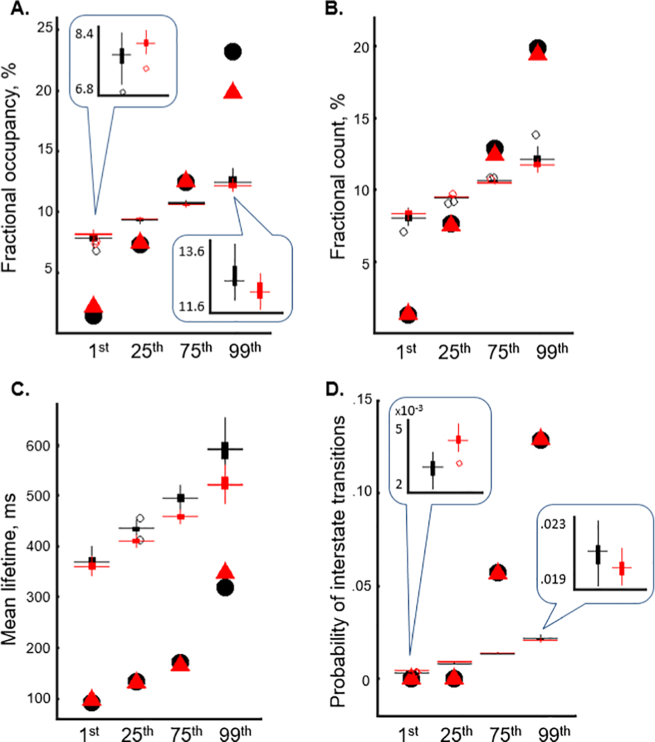
Temporal characteristics of 10 HMM states inferred in the simulated datasets compared to those in the real datasets. In each simulated multivariate dataset, fractional occupancy (A), fractional count (B), and mean lifetime (C) were computed for each state, for the sets of data points corresponding to the data of each CH participant. State-to-state transition probabilities (D) were also computed for the data-point sets corresponding to the data of each CH participant. We then determined values of these parameters corresponding to the 1st, 25th, 75th, and 99th percentiles in each simulated dataset. Boxplots show distributions of these values (as described in Fig. 6) across 50 datasets simulated based on the all-participant real dataset (in black) and 50 datasets simulated based on the CH-participant real dataset (in red). Corresponding parameter values in the all-participant real dataset (black solid circles) and in the CH-participant real dataset (red triangles) are shown for comparison. Inserts enlarge selective boxplots. The mean lifetimes of the HMM states were shorter in the real than simulated data (p < 0.05, corrected), and the within-participant variance in the other three temporal parameters between the HMM states was higher in the real than simulated data (p < 0.05, corrected).